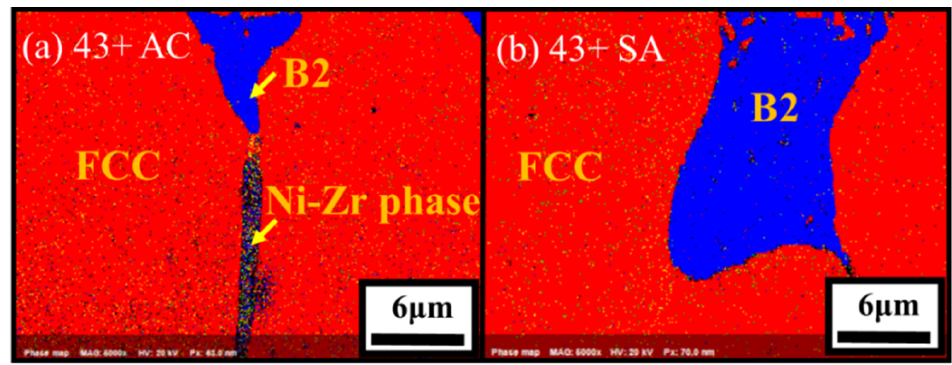
Figure 3. EBSD phase mapping for the alloys ( a ) 43+ AC and ( b ) 43+ SA. Meanwhile, the area fraction of the B2-NiAl phases was measured and the results are shown in Figure 4. The area fraction of B2-NiAl phases increased with Ti in as-cast conditions, up to 12%. For all alloys, the area fraction of B2-NiAl phases was reduced after solution annealing, suggesting partial dissolution. Meanwhile, the reduction of the interdendritic B2-NiAl phases was less for alloy 44+ (with the highest Ti) compared to alloys with lower Ti. On the other hand, the area fraction of Ni-Zr rich phases were 1–2% for the alloys in the as-cast condition, which were further reduced to 0.5–1% after solution annealing.